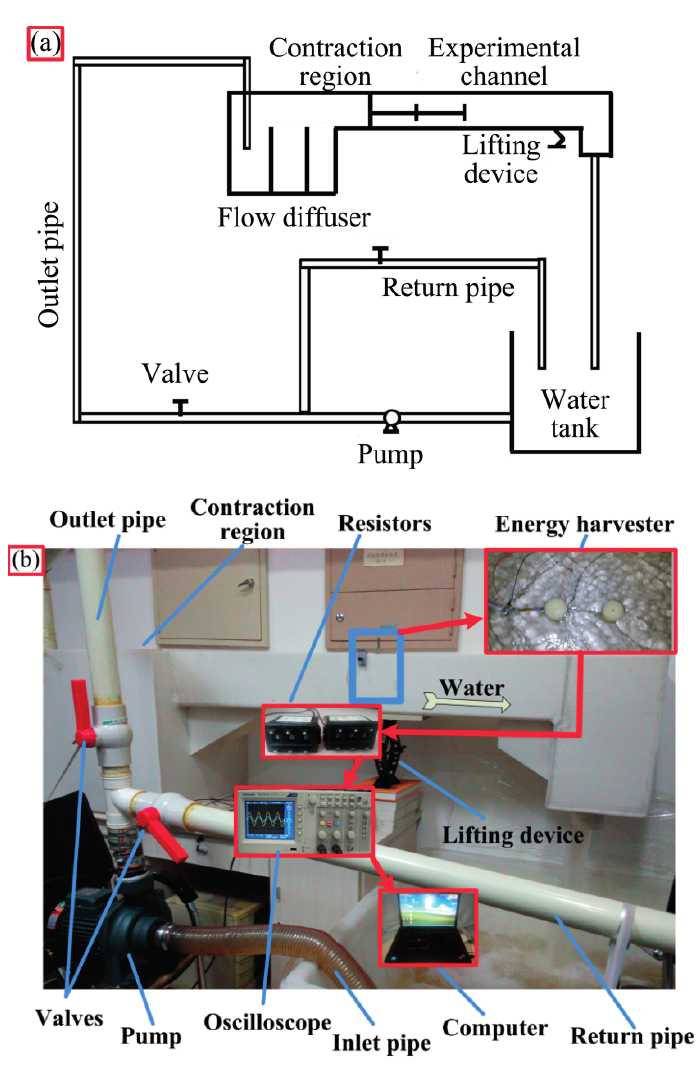
Figure 2. Schematic diagram of the experimental set-up and a picture of the experimental platform: ( a ) schematic diagram of the experimental set-up; ( b ) experimental platform.